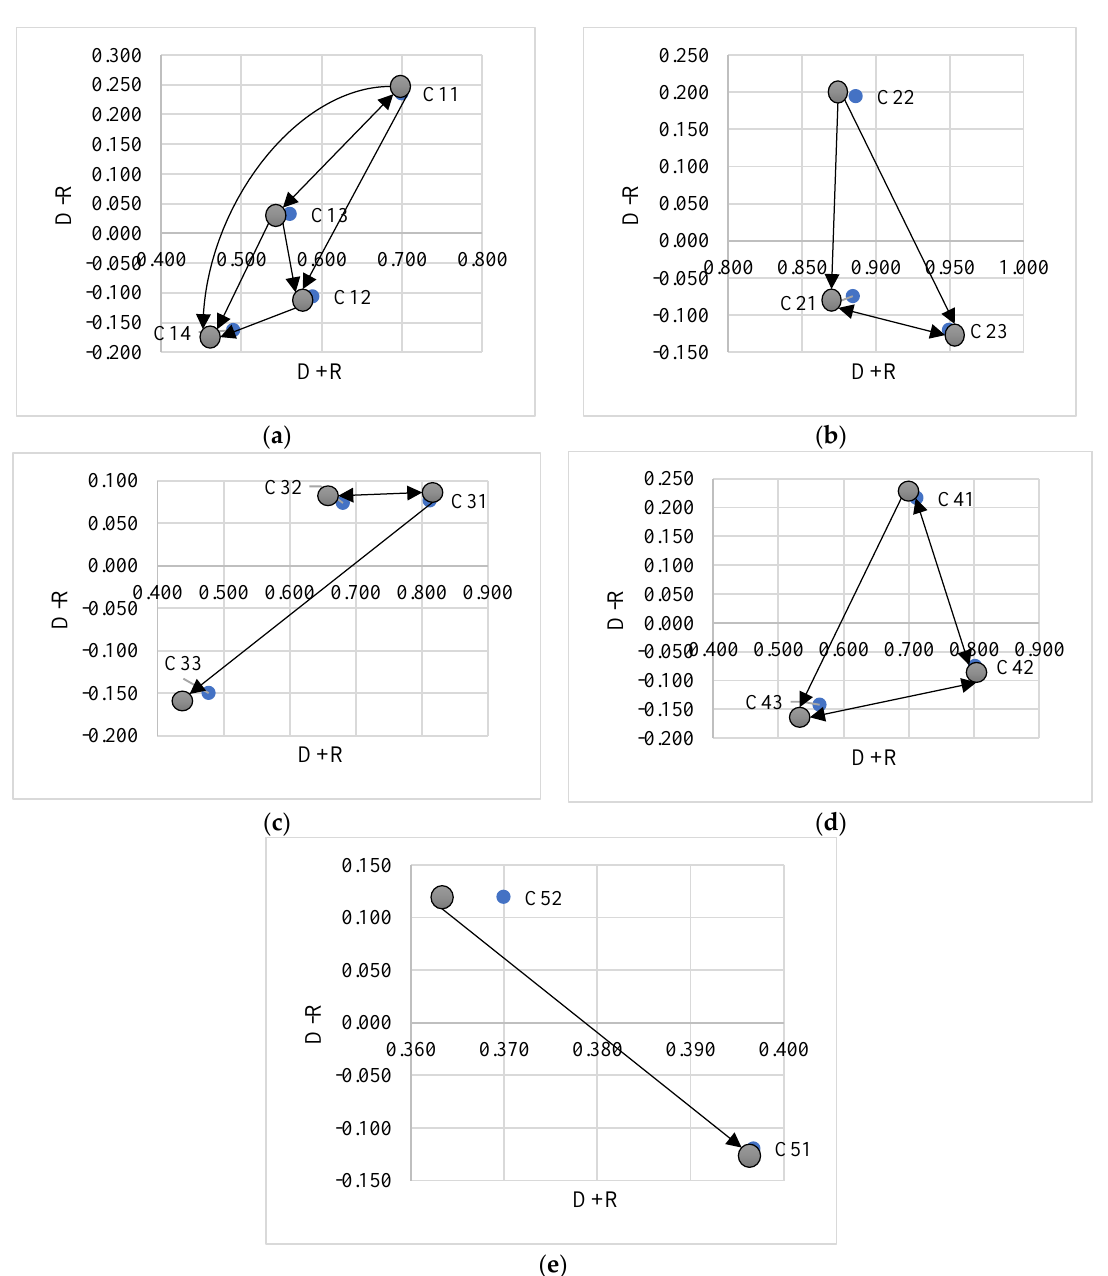
Figure 4. Causal chart of barriers (Symbol criteria are presented in Tables A2 and A3).